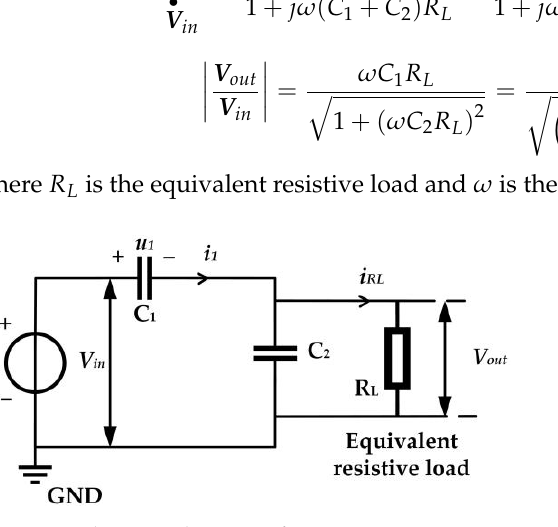
Figure 3. The Influence of f requency f and equivalent resistive load